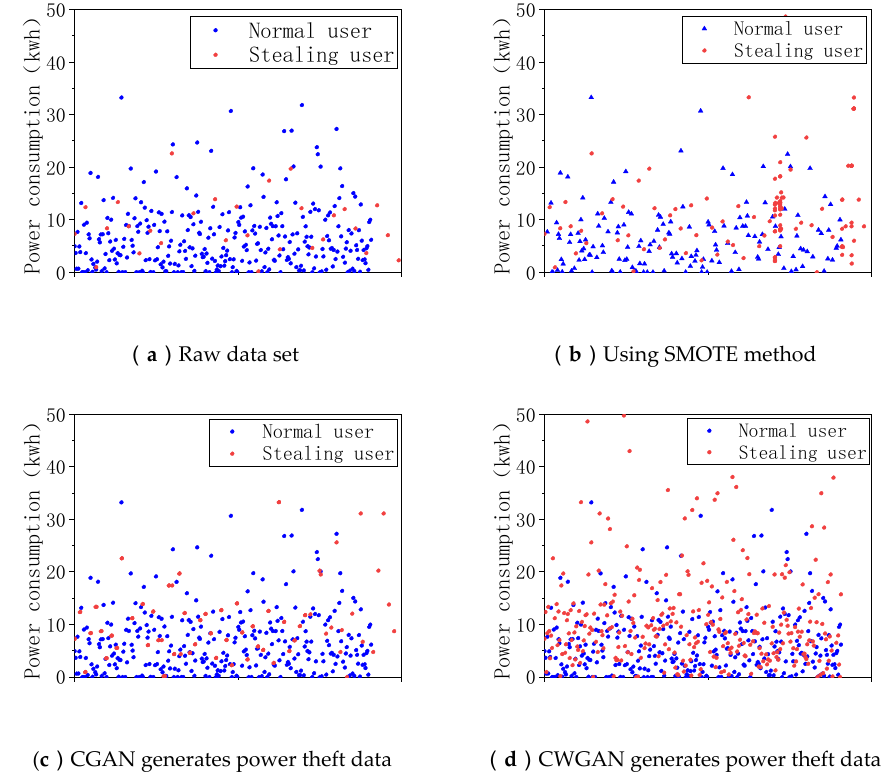
Figure 4. Comparison of different methods for processing imbalanced data sets.